Question: Summarize what this figure shows in one sentence.
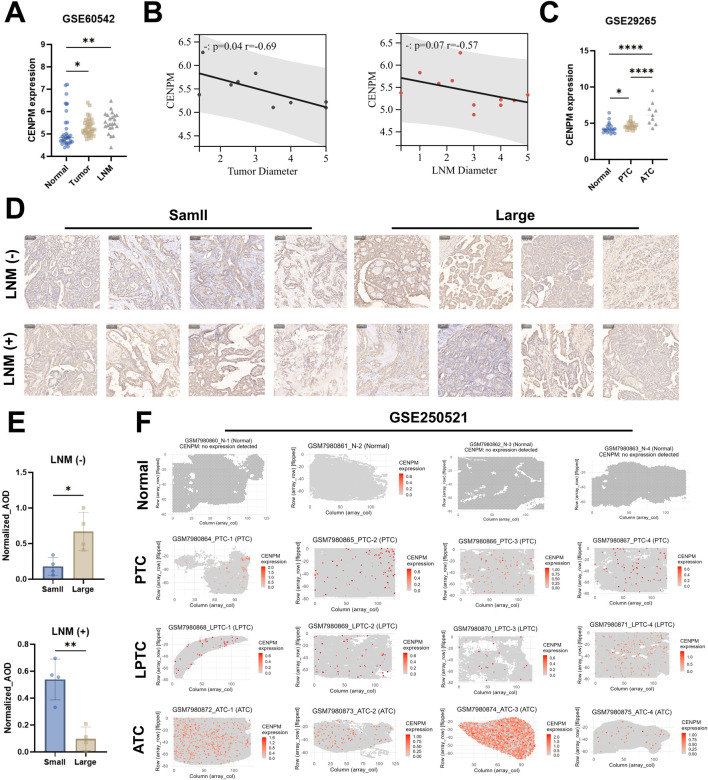
Answer: Independent validation and experimental verification of CENPM (A) CENPM expression in normal thyroid tissue, primary THCA, and metastatic lymph nodes in the GSE60542 dataset (B) Correlation analysis of CENPM expression with primary tumor diameter and metastatic lymph node diameter in the GSE60542 dataset (C) CENPM expression in normal thyroid, PTC, and ATC tissues in the GSE29265 dataset (D) Representative IHC images of CENPM in LNM− and LNM + THCA tissues subdivided by median tumor diameter (small vs. large). Scale bar, 100 µm (E) Comparison of AOD values across the indicated subgroups (F) CENPM expression levels in normal, PTC, LPTC, and ATC tissues from the GSE250521 spatial transcriptomics dataset. *P < 0.05, **P < 0.01, ****P < 0.0001.